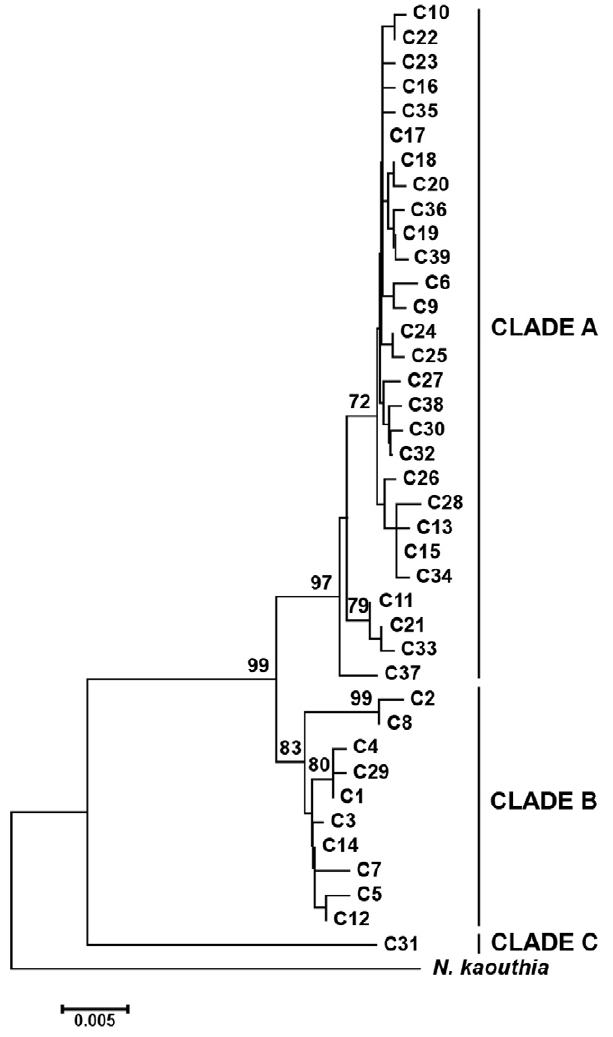
Figure 3. Maximum-likelihood tree for all 39 haplotypes of Naja atra and for one outgroup taxon. Labels are haplotype identifica- tion numbers. Values above branches indicate support for each node based on maximum likelihood. Bootstrap values below 70% are not shown.